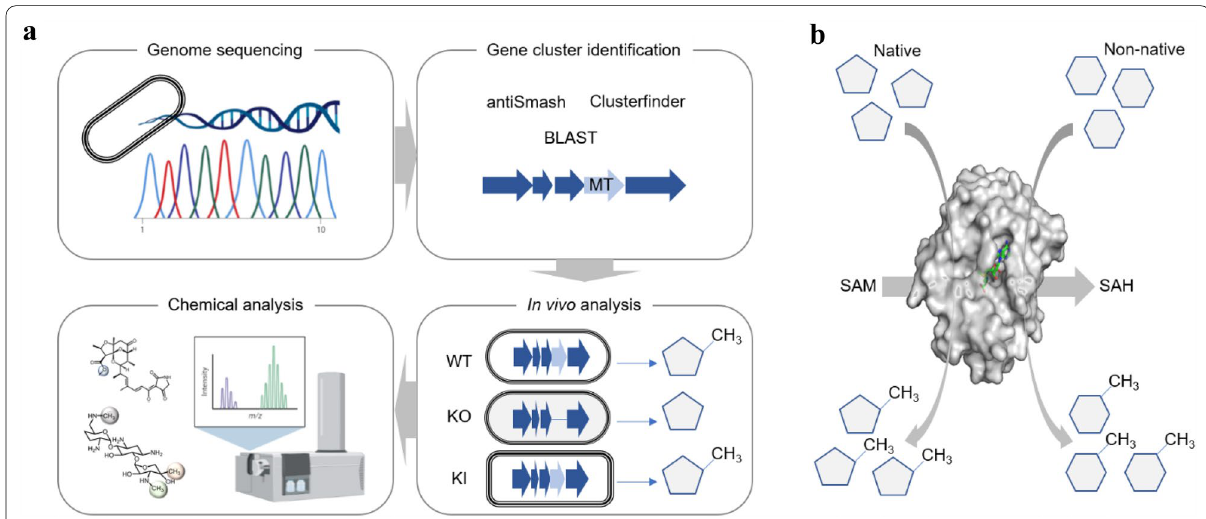
Fig. 1 Illustrations of methods to identify the desired methyltransferases activities. a Genomic and chemical screening methods are used to identify the novel methyltransferases from native microbial hosts. First, genome sequencing is carried out to obtain the genetic information. Second, in silico tools are used to identify the putative methyltransferase gene. For natural product biosynthesis, such methyltransferases are often found in a biosynthetic gene cluster in microbial hosts. Third, mutant strains with knock-out (KO) or knock-in (KI) to delete or overexpress the putative methyltransferases gene, respectively, are constructed. Finally, chemical screening is then carried out to profile the non-methylated intermediates or elevated methylated products from these mutant strains as compared to wildtype (WT) strain. Some illustrations were created with BioRender.com. b Promiscuous methyltransferases are used to catalyze structurally similar substrates to achieve the desired methylation reaction. The 3D model is caffeate O-methyltransferase from Homo sapiens (PDB: 3BWY). The bound SAH is shown in